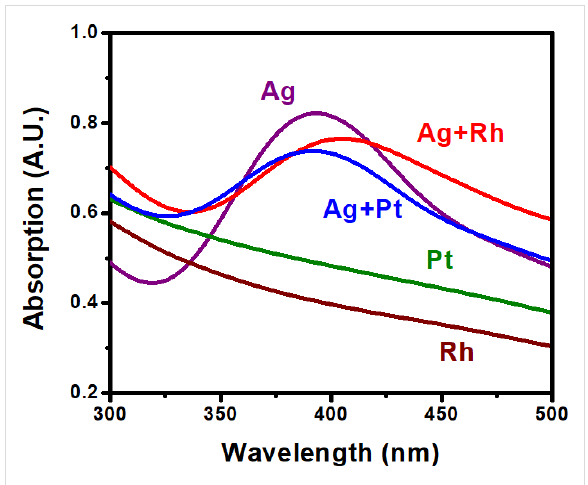
Figure 2: UV–vis absorption spectra of the monometallic Ag, Pt, Rh, and the colloidal Ag–Rh and Ag–Pt heterostructure solutions.